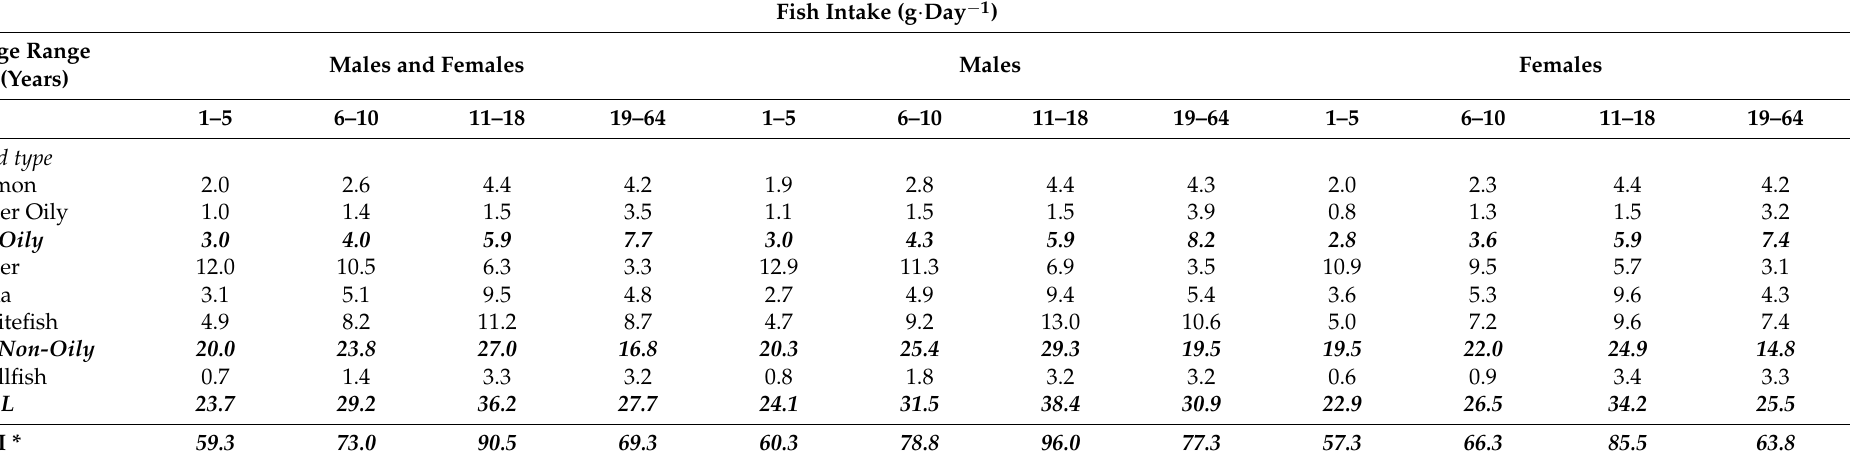
Table 4. Seafood intake (g · day − 1 ) of UK individuals, based on age and gender, including non-consumers, calculated from NDNS disaggregated data seafood type (years 1–8 combined